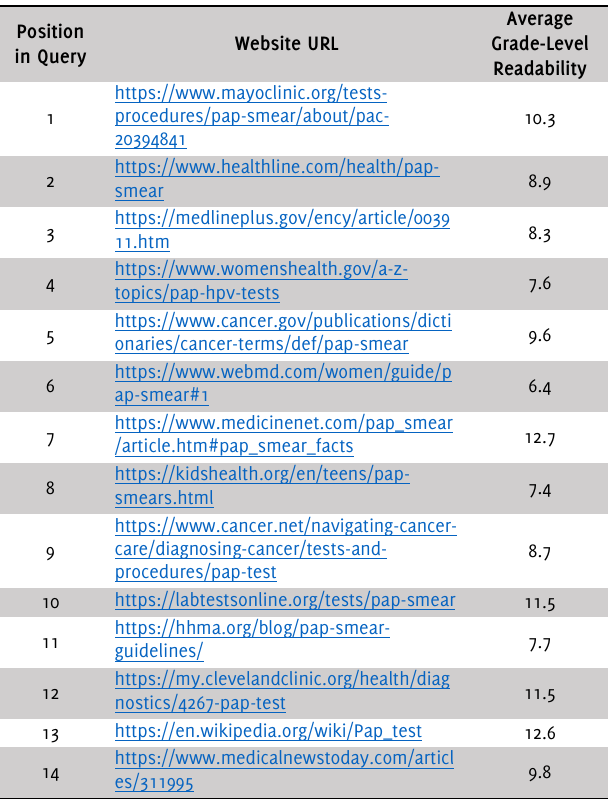
Table 1 . Comparison of Website URL Position in a Query Following a Google Search for “pap smear” and Average Grade-Level Readability as Determined Using Four Standardized Readability Indices.